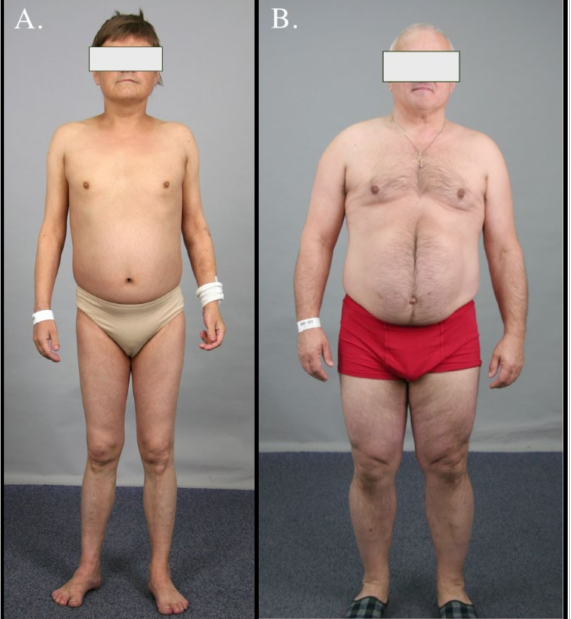
Figure 1. ( A ) Case 3—a 35-year-old female with congenital adrenal hyperplasia (CAH), a short stature (146 cm ± 2.7), breast underdevelopment, and hirsutism (facial hair); ( B ) Case 6—a 52-year-old male with CAH, a short stature (164 cm ± 2), and abdominal